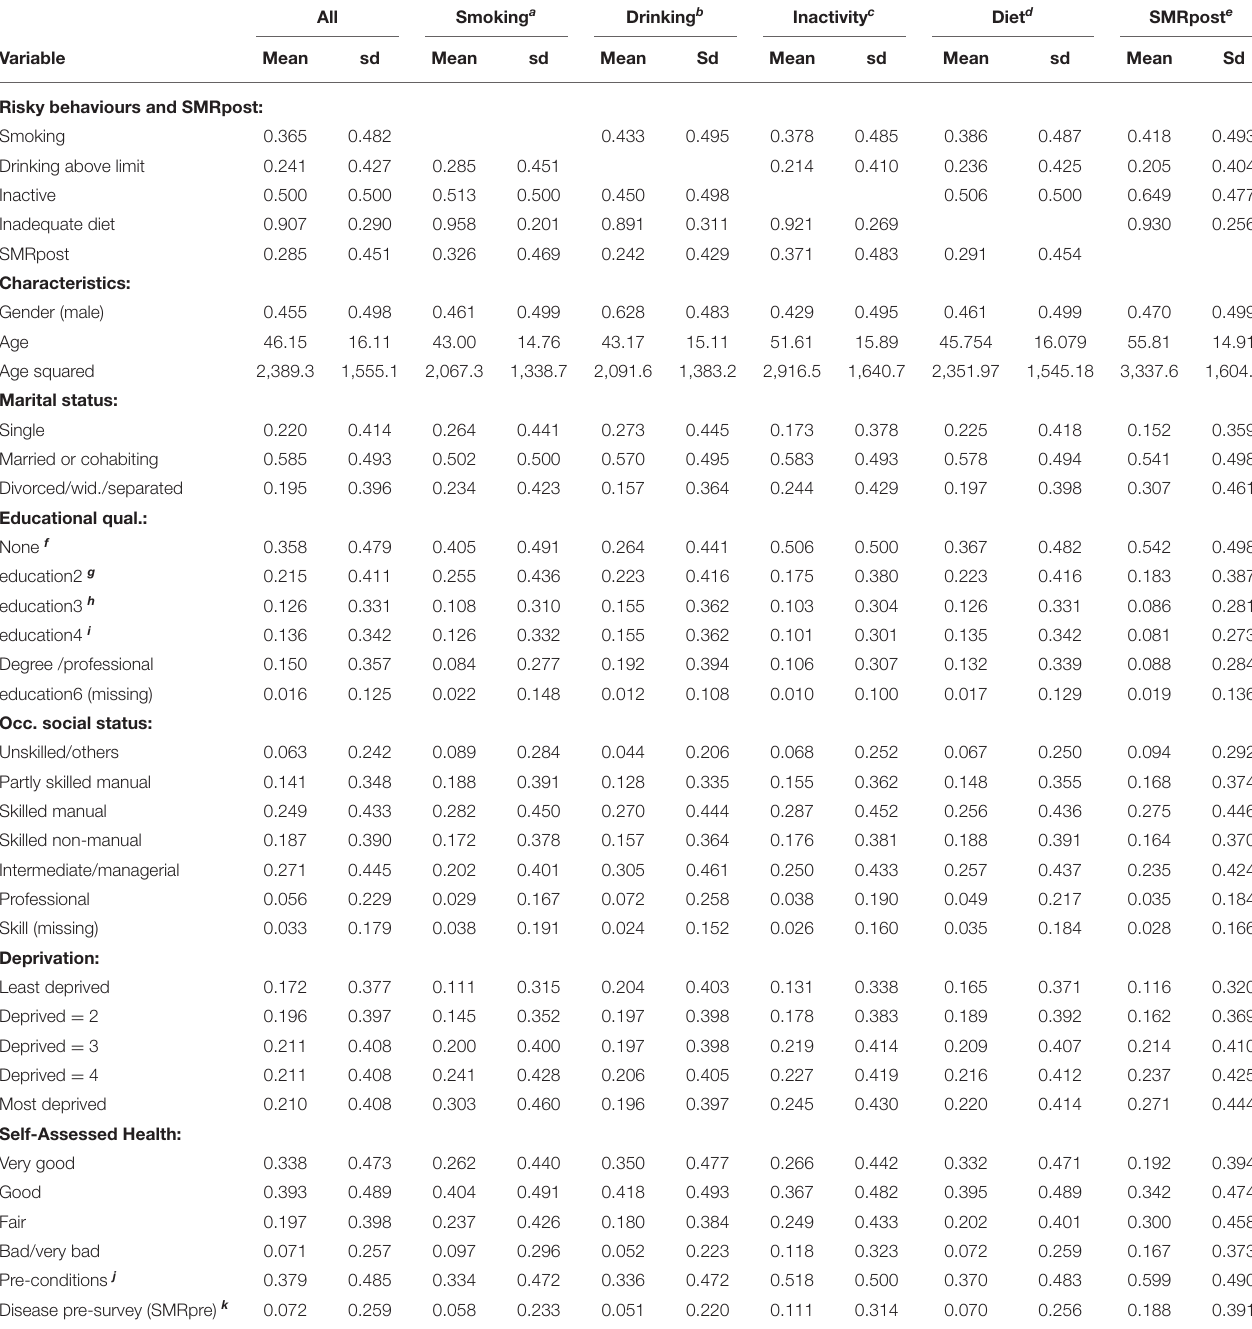
TABLE 1 | Descriptive statistics of risky behaviours, disease outcome, and other characteristics ( N = 20,751). All Smoking a Drinking b Inactivity c Diet d SMRpost